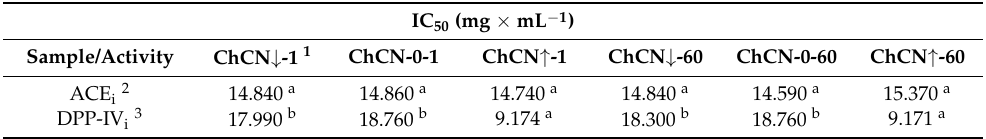
Table 6. ACE- and DPP-IV-inhibiting (IC 50 ) potential of the water-soluble extracts derived from Gouda with the modified content of β